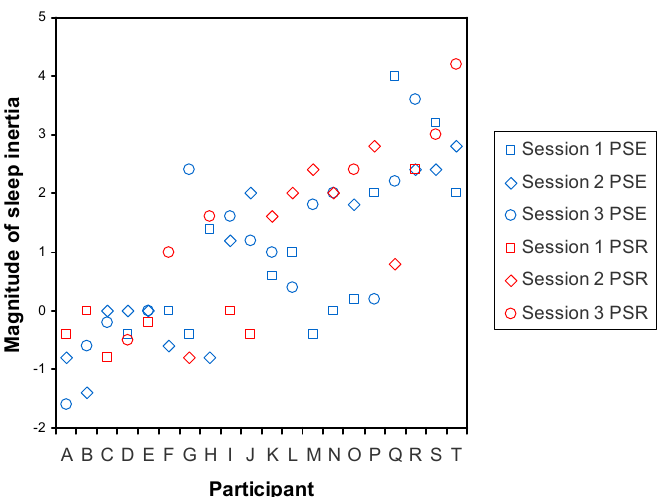
Figure 6. Systematic interindividual differences in the effect of SI on sleepiness following the baseline sleep period, illustrated by individual participants. Each participant underwent three separate laboratory sessions, the data of which are differentiated by different symbols. Randomized over the participants, one of the three laboratory sessions involved a PSR condition with a 6-h baseline sleep opportunity, whereas the other two laboratory sessions involved a PSE condition with a 12-h baseline sleep opportunity; these are differentiated by color. For this figure, the magnitude of the SI effect was determined as the sleepiness score on the KSS-1 in the test bout immediately after scheduled awakening, expressed relative to baseline sleepiness calculated as the mean of the sleepiness scores on the KSS-1 in the subsequent test bouts from 12:00 up to (but not including) 22:00 (see Figure 1). The abscissa shows the 20 individual participants, labeled A through T, ordered by their average magnitude of the SI effect, such that the least SI-susceptible individuals are on the left and the most SI-susceptible individuals are on the right. The figure shows that individuals differed substantially in the magnitude of the effect of SI on sleepiness, while the effect was relatively consistent within individuals, reflecting stable interindividual differences in the magnitude of SI.